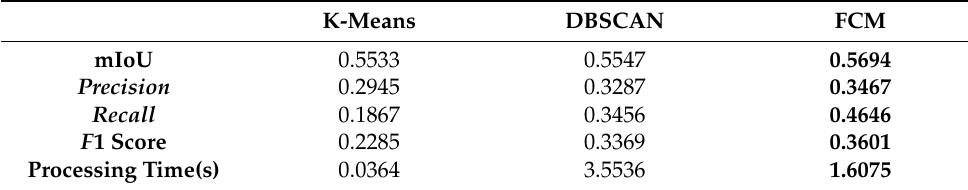
Table 2. Road extraction results obtained by different clustering methods.